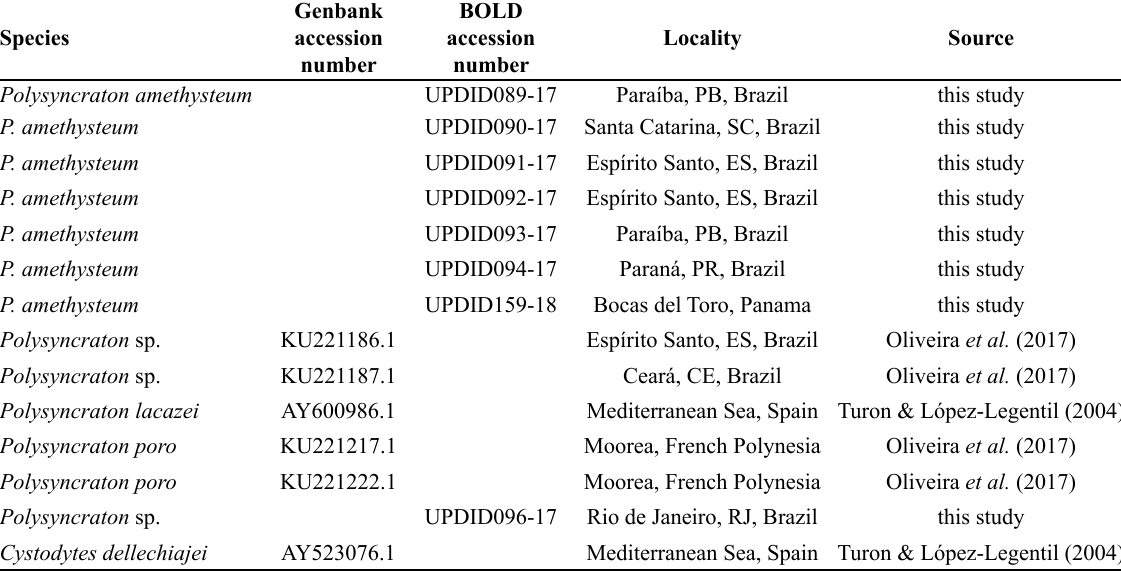
Table 1. Accession numbers of the specimens, sequences IDs and the localities where the samples were